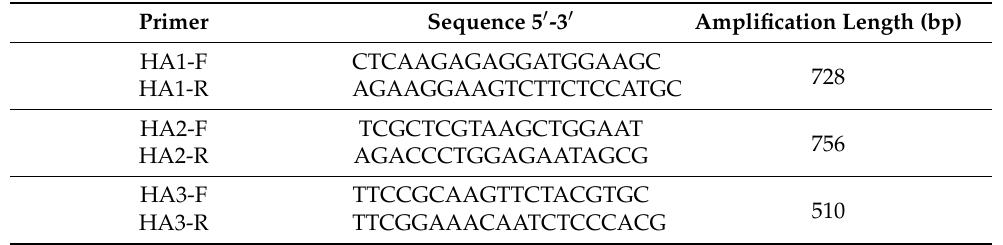
Table 1. List of primers used in sanger sequencing.